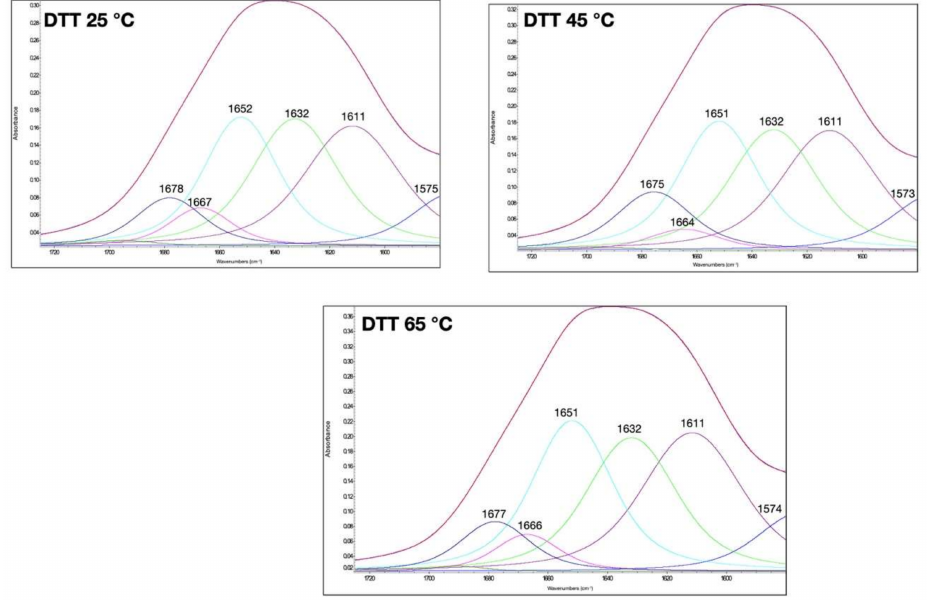
Figure 4. Amide I band of gluten at 25, 45, and 65 ◦ C and with dithiothreitol (DTT) treatment. The secondary structure determination by the curve-fitting procedure is indicated. Table 1. Gluten secondary structure (FTIR spectroscopy) expressed in area (%) and creep strain (%) as a function of temperature, ascorbic acid (AA), diacetyl tartaric acid ester of monoglycerides (DATEM), and dithiothreitol (DTT) a